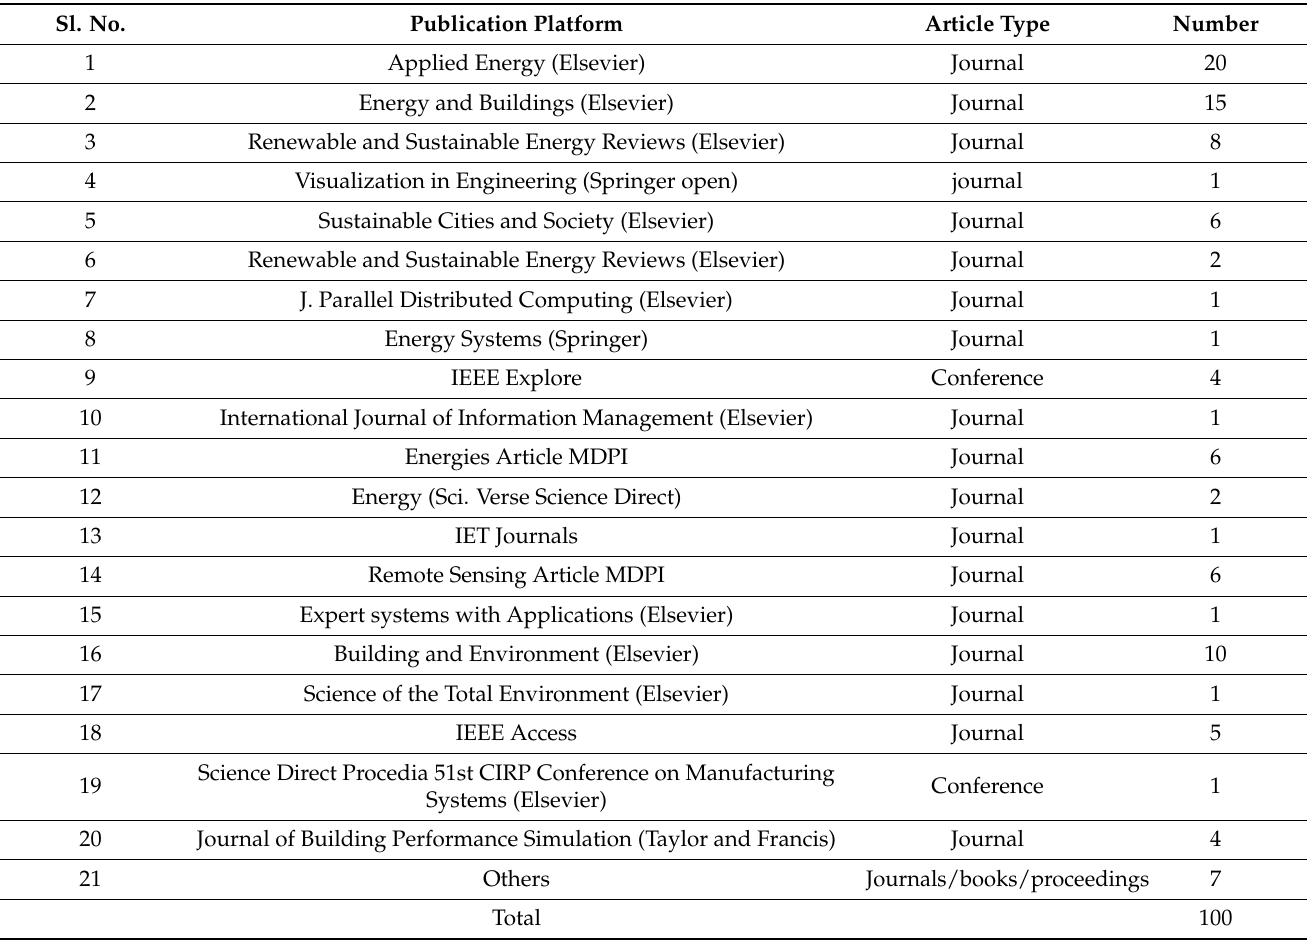
Table 1. Summary of the survey